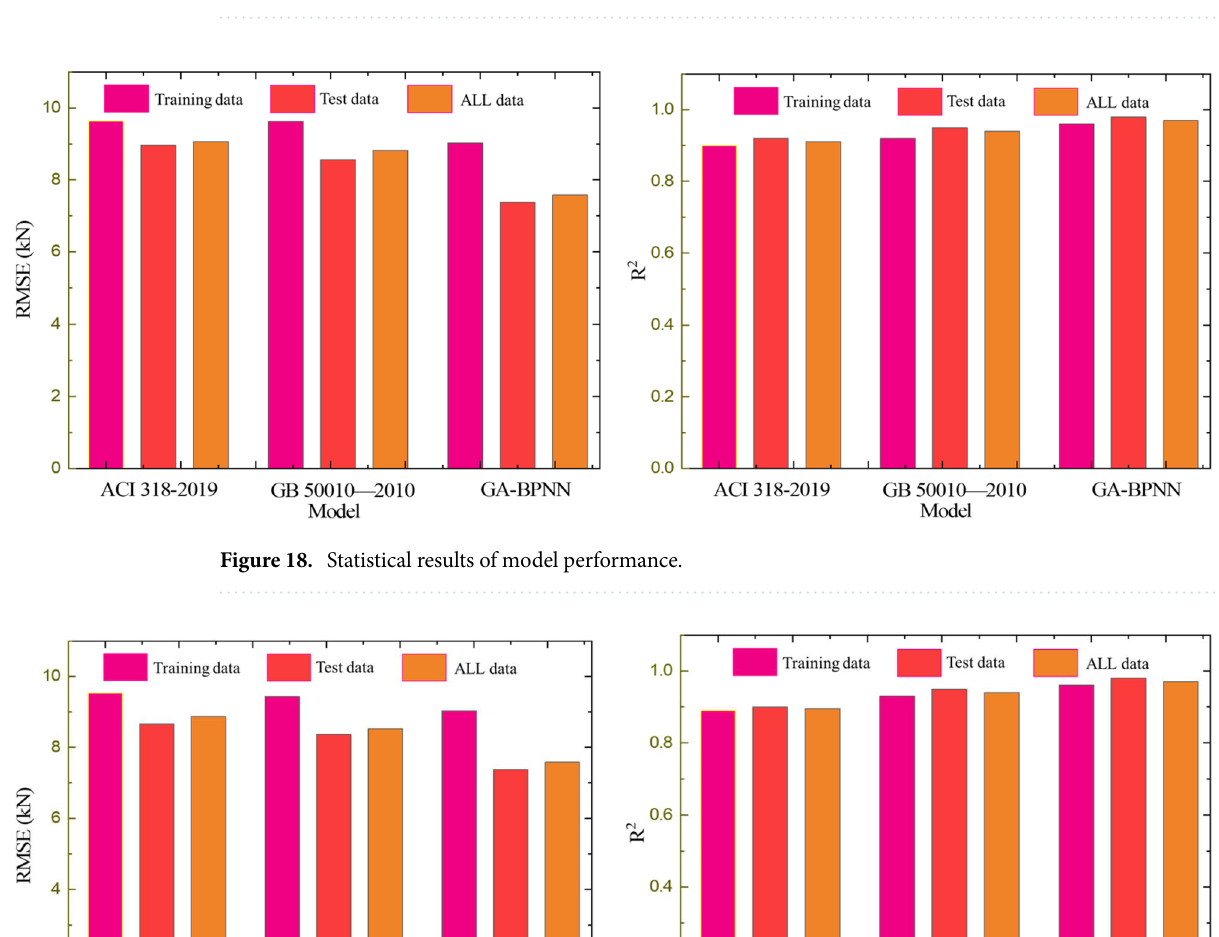
Figure 17. GA-BPNN prediction results {( a ) Training set, ( b ) Testing set}.